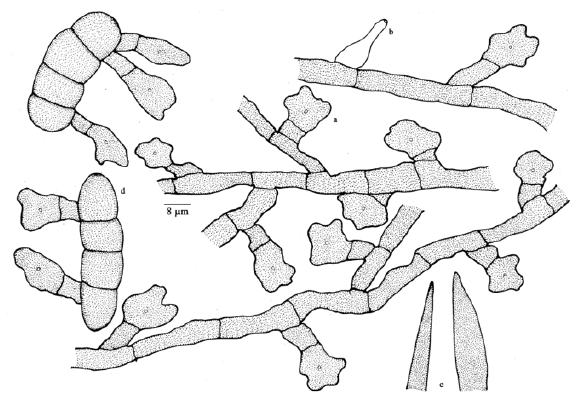
Figure 104. Meliola oleicola a - Appressorium; b - Phialide; c - Apical portion of mycelial setae; d -